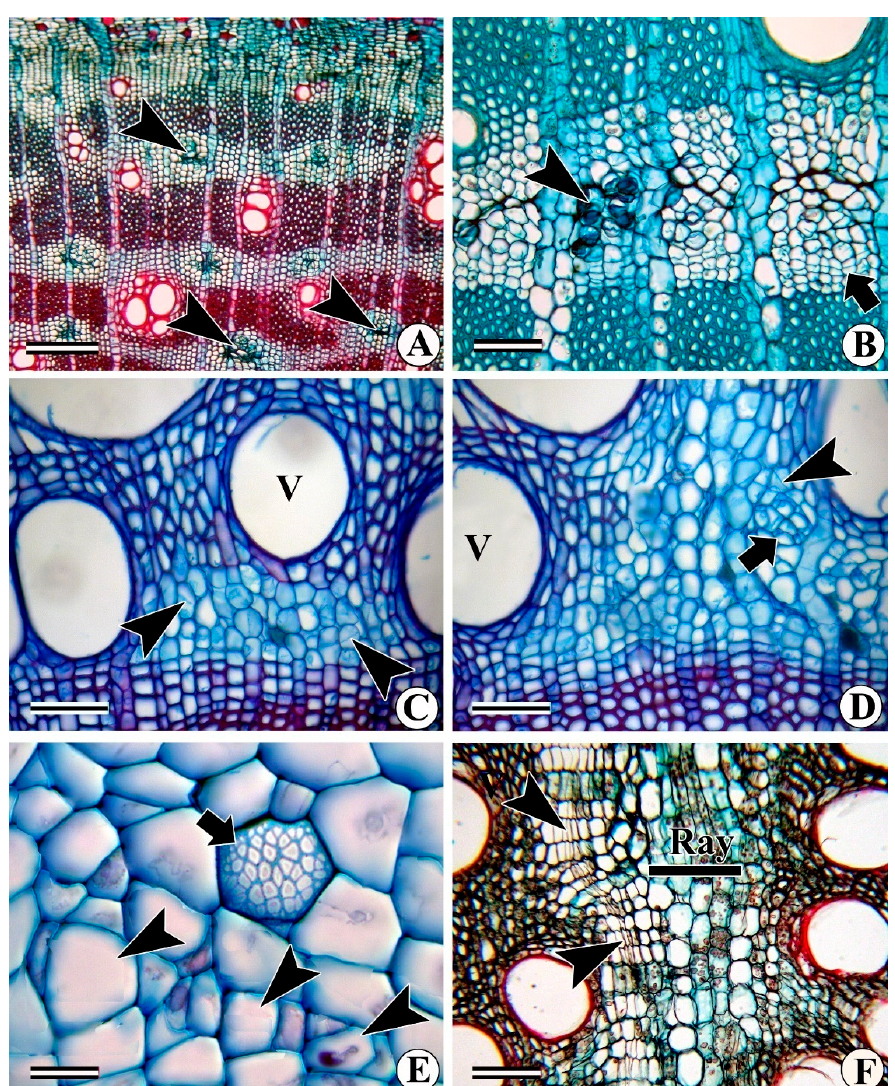
Figure 4. Transverse view of mature stems showing interxylary phloem. ( A ) Interxylary phloem islands (arrowheads) embedded within the secondary xylem of S. oleoides . ( B ) Associated parenchyma showing division and radially flattened cells like cambium (arrow). Arrowhead indicates previously formed sieve elements in S. persica . ( C ) Parenchyma strand in a relatively young stem showing initiation of cell division (arrowheads) and formation of sieve elements in A. elliptica . ( D ) Fully grown thick stem of A. elliptica showing recently formed sieve elements (arrow) and continuation of cell division (arrowhead) in adjacent parenchyma cell. ( E ) Structure of sieve elements in transverse view showing simple sieve plate (arrow). Note the variation in the outline shape and size (arrowheads). ( F ) Initiation of meristematic activity (arrowheads) in the parenchyma cells adjacent to the xylem rays. A horizontal bar indicates the width of the xylem ray in L. reticulata . Abbreviation : V = vessel. Scale bars: A = 200 µm; B–D, F = 100 µm; E = 20 µm.